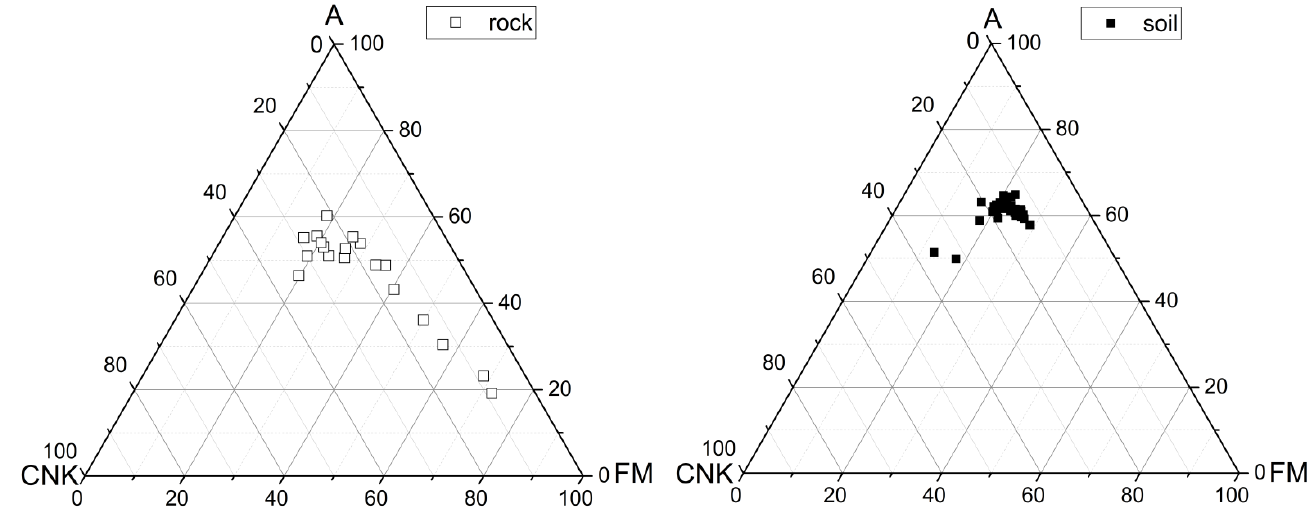
Figure 6. The A-CNK-FM diagram for parent material and soil.